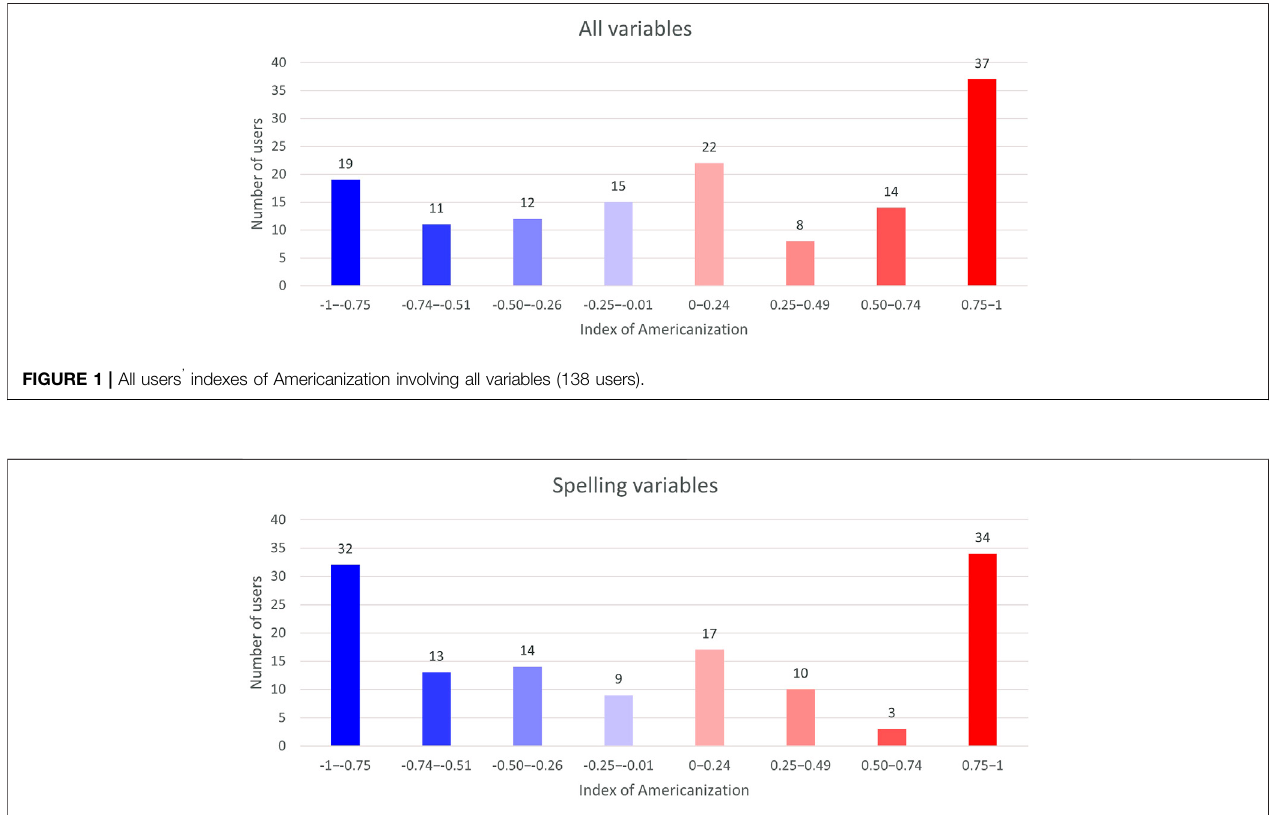
FIGURE 2 | All users ’ indexes of Americanization involving all spelling choices (132